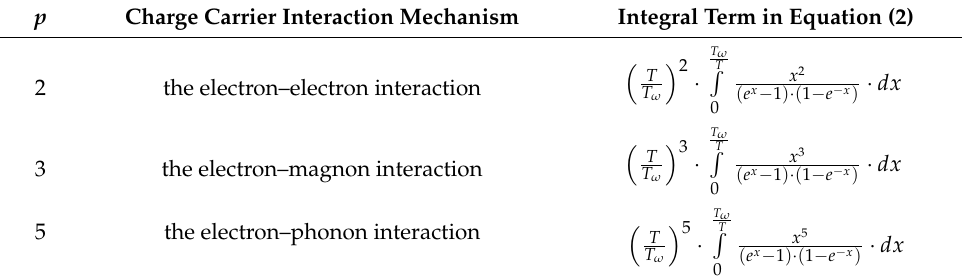
Table 1. p -value in generalized Bloch–Grüneisen equation (Equation (2)) and the interation mecha- nism designated for that value